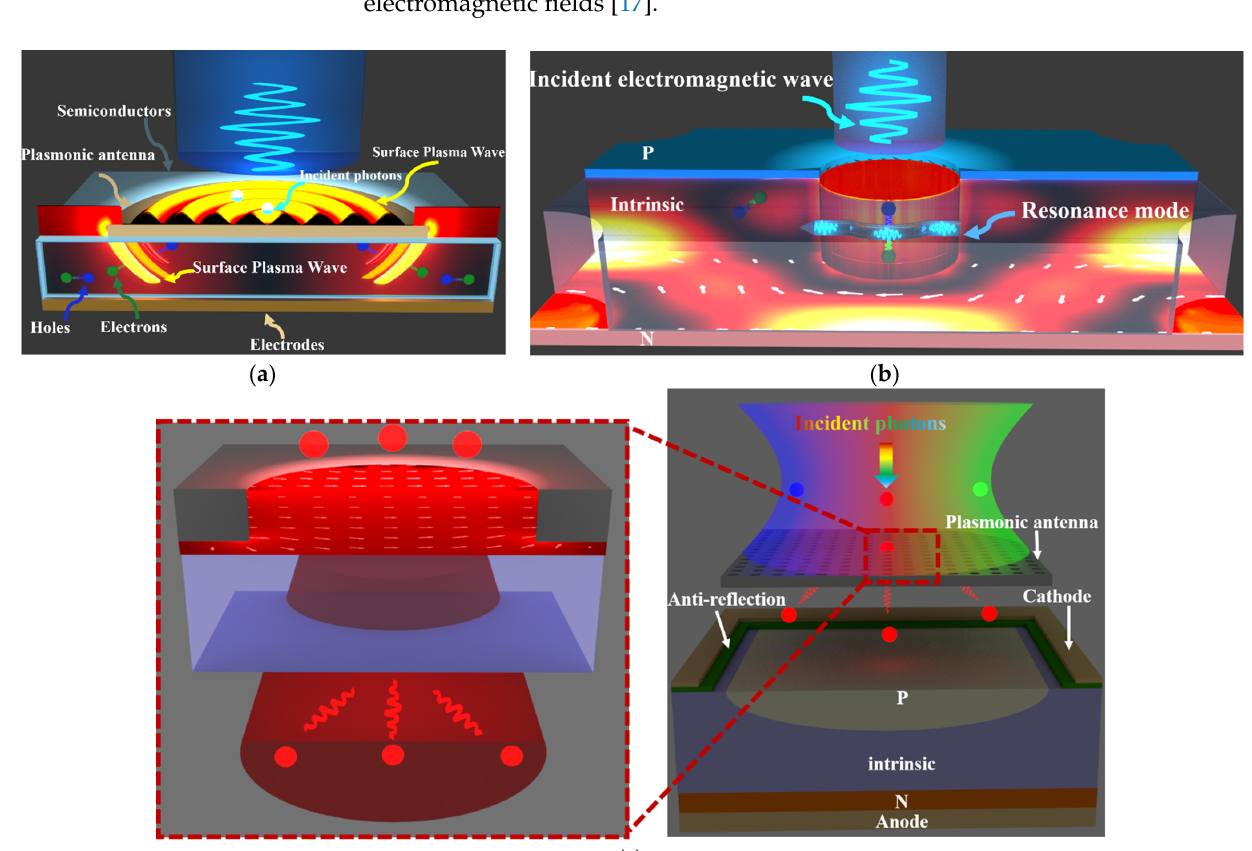
Figure 2. Different functions of optical antennas in photodetection. ( a ) Near-field scattering, causing locally increased ab- sorption, ( b ) coupling the incident light into resonant modes and injecting the photo-excited carriers into the semiconductor, and ( c ) far-field scattering, leading to a prolonged optical path (collect and re-emit photons)